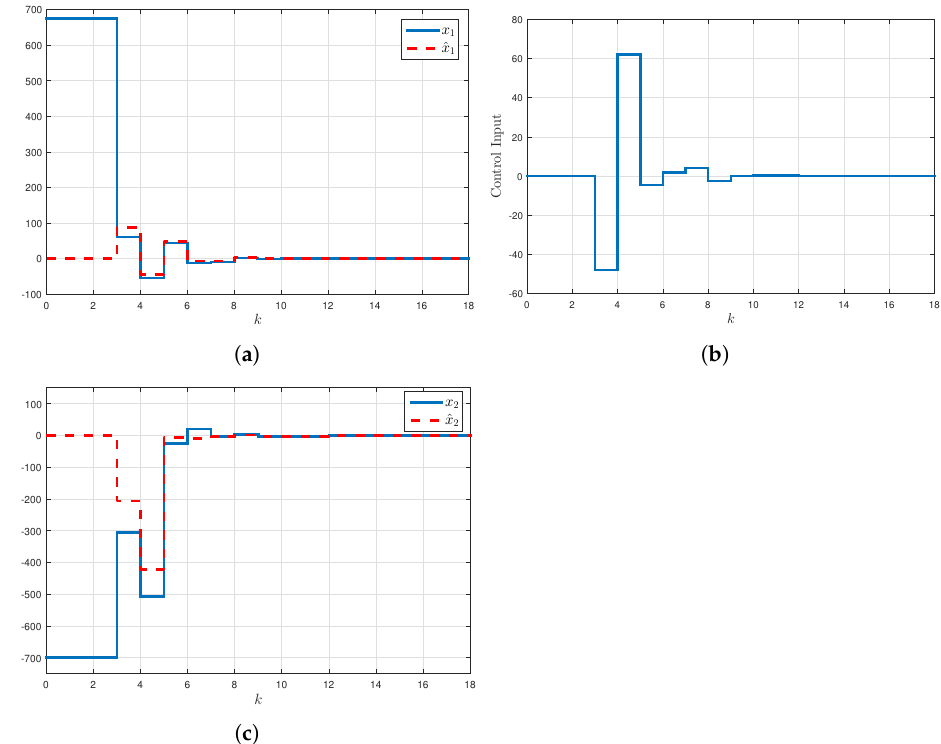
Figure 3. Simulation results for example 1. ( a ) Response and estimate trajectories of x 1 . ( b ) Input trajectory. ( c ) Response and estimate trajectories of x 2